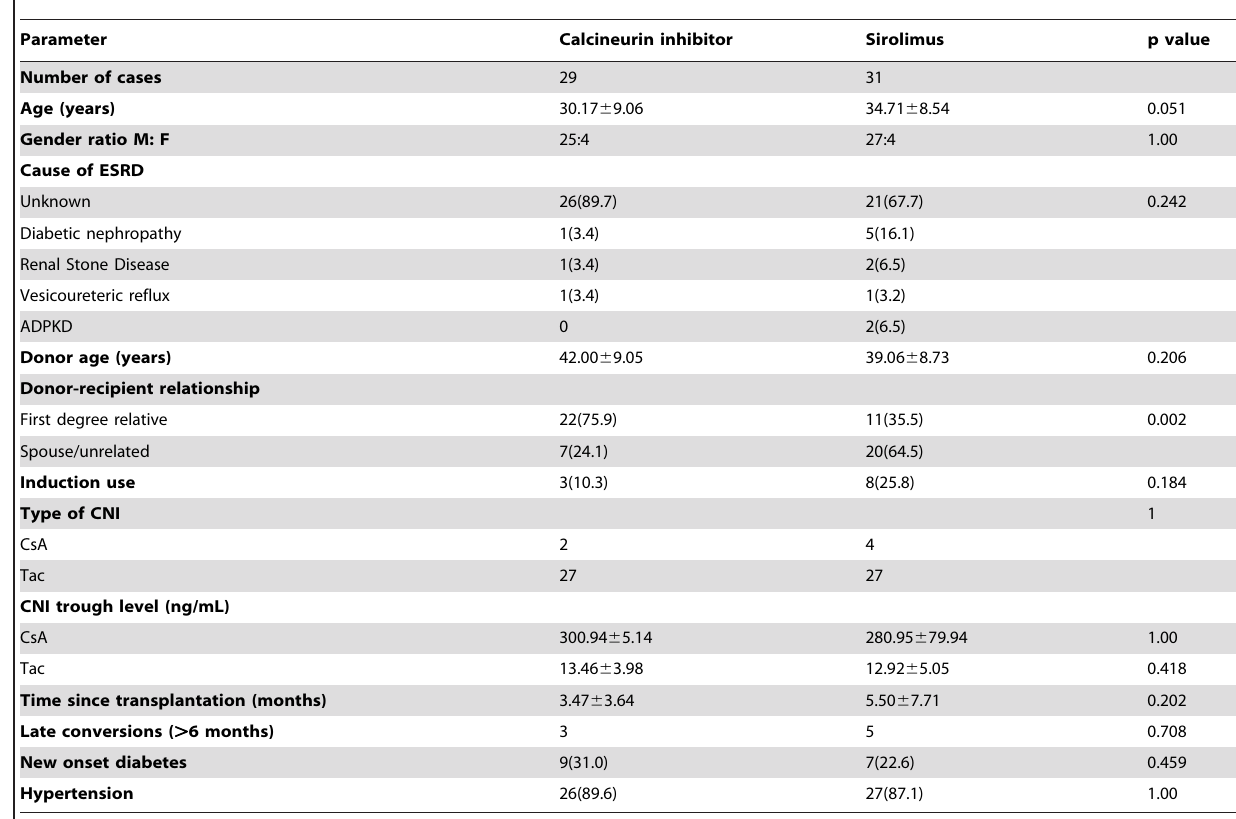
Table 1. Baseline characteristics of study subjects in the two groups.